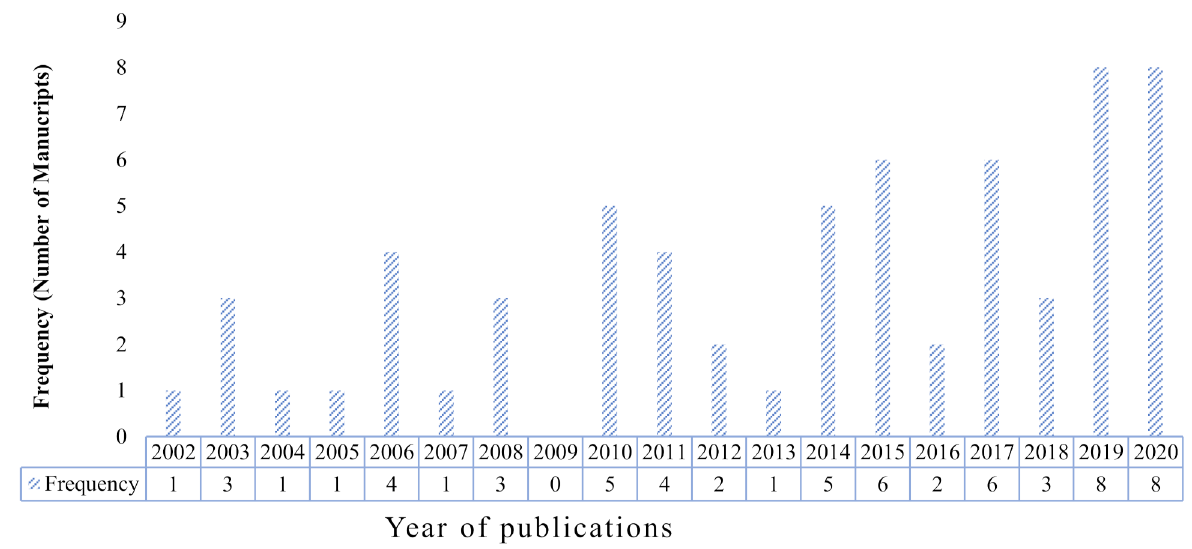
Figure 2. Timeseries analysis of manuscripts; Source: authors’